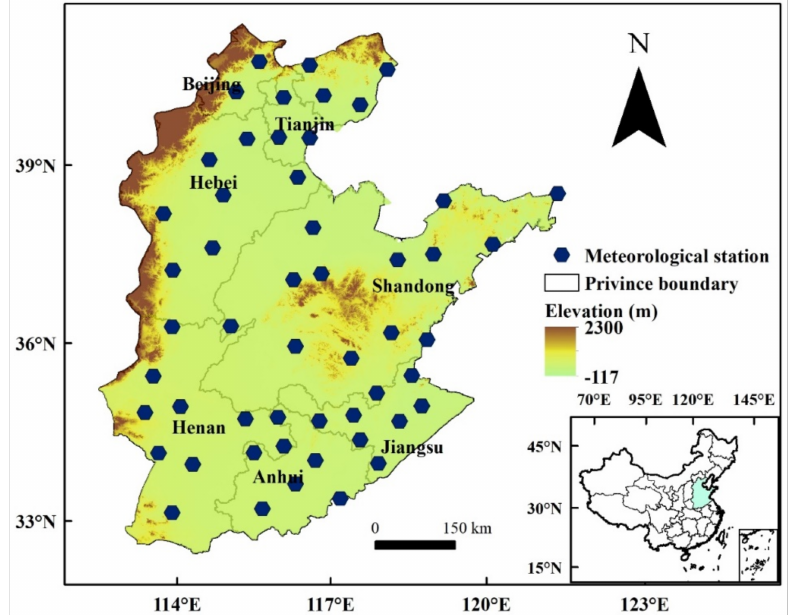
Figure 1. The spatial distribution of 52 meteorological stations in the North China